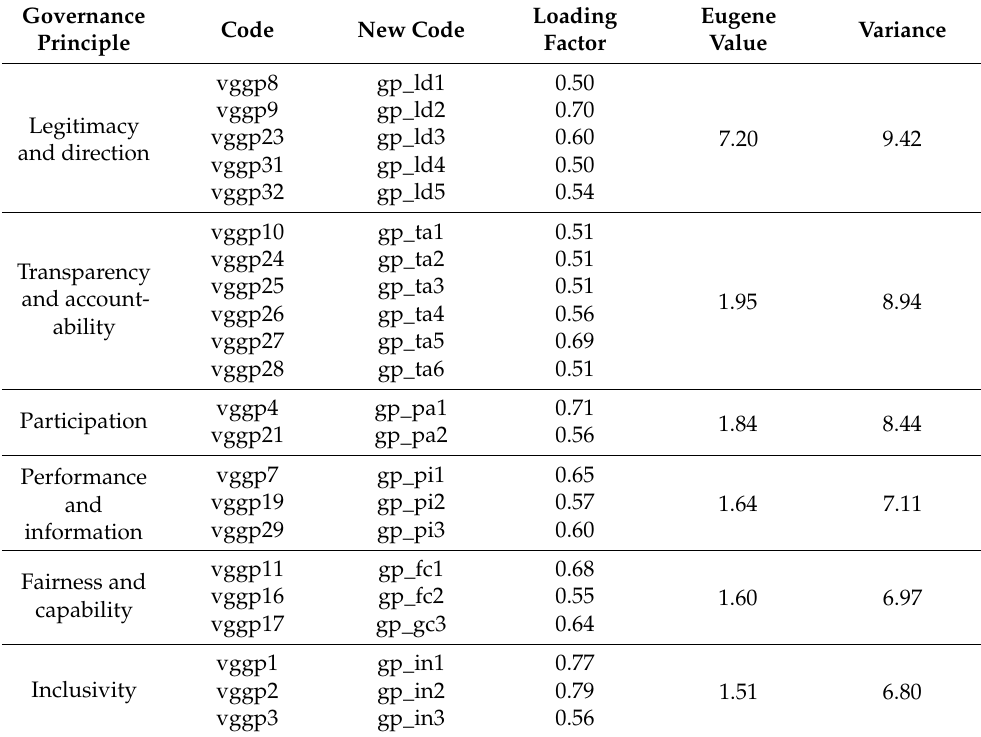
Table 6. Exploratory factor analysis of governance